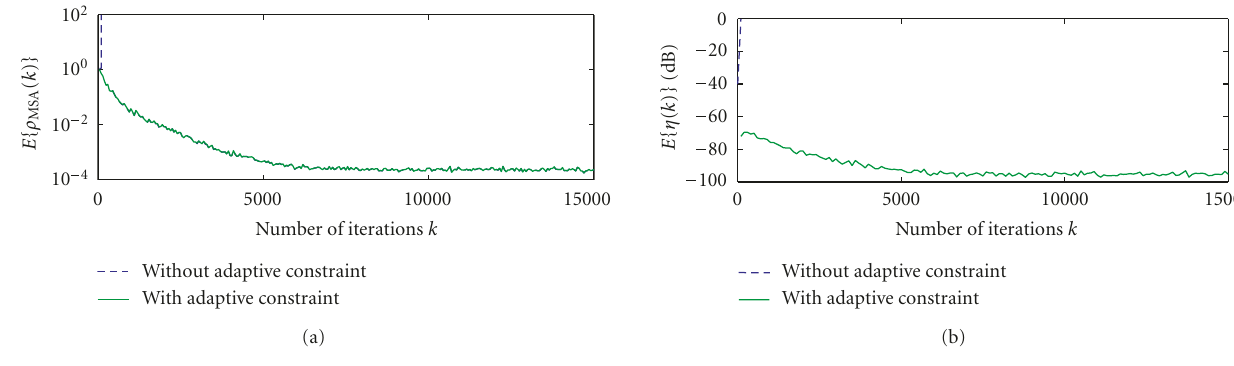
Figure 4: Evolutions of (a) E { ρ MSA ( k ) } and (b) E { η ( k ) } for the spatiotemporal minor subspace algorithms.